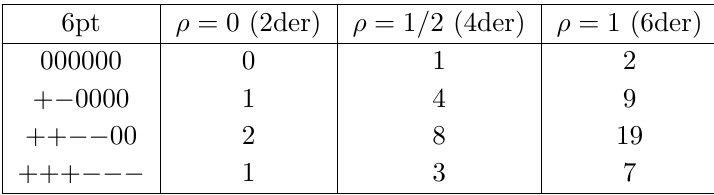
Table 2 . The number of independent monomials for pure scalar 6pt